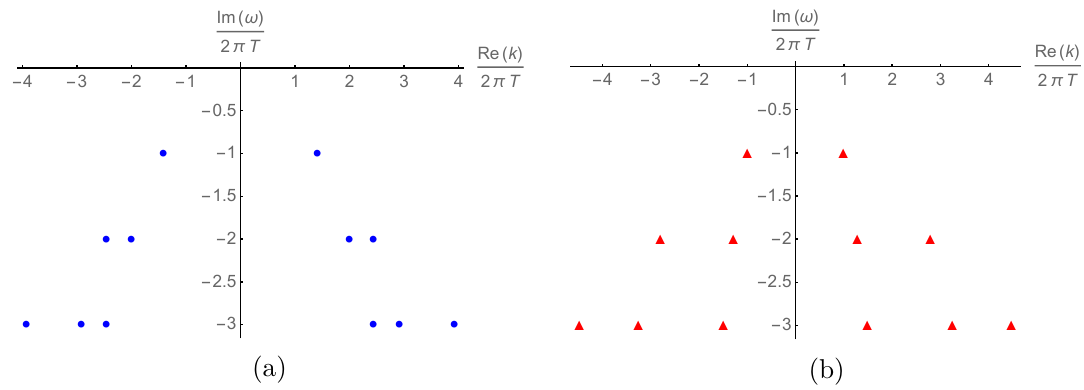
Figure 6 . The first three order pole-skipping points of axion field χ ( r ) in Lifshitz spacetime with linear axion fields and hyperscaling violating factor. (a) z = 2 , θ = 3 ; (b) z = 2 . 5 , θ = 2 . 5